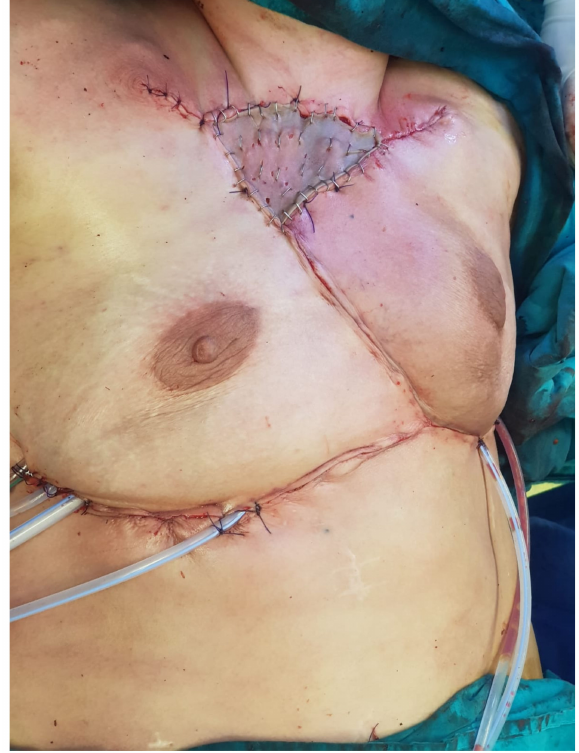
Figure 13. Final postoperative